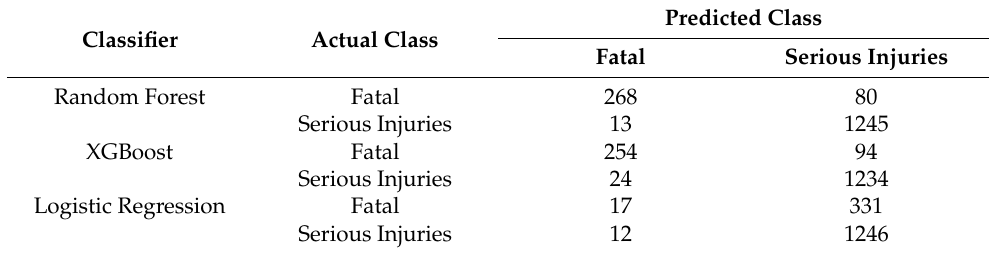
Table 5. Confusion metrics for the classifier modes.